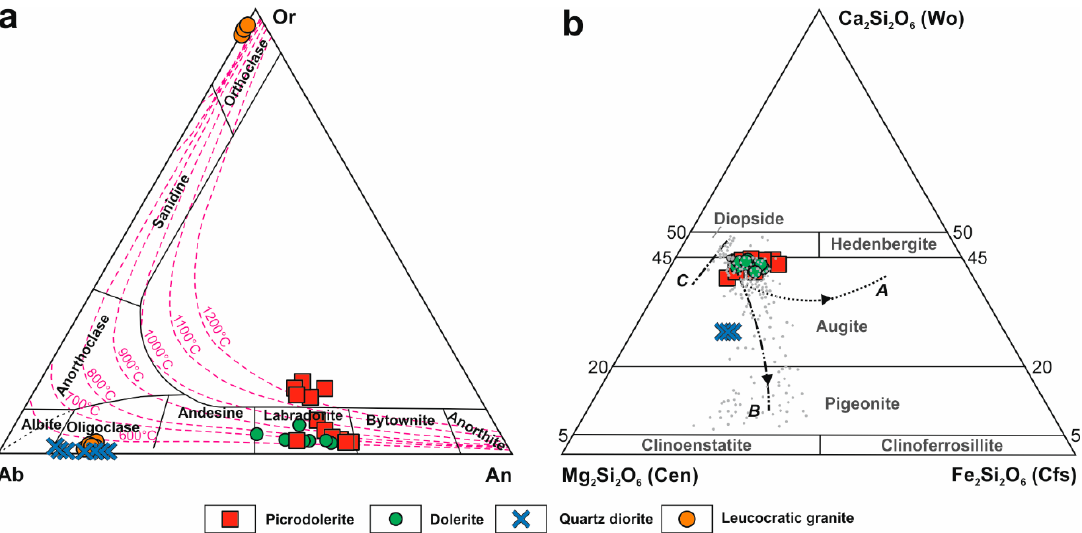
Figure 5. Composition of minerals from the dike rocks on classification diagrams: for plagioclases from [38] ( a ), for clinopyroxenes from [39] ( b ). Composition lines for clinopyroxenes are given for igneous rocks of: A —intraplate settings, picrites, subalkaline gabbros and syenites, Skaergaard intrusion, Greenland [40]; B —active continental margin settings, basalts, basaltic andesites, dacites, Hudson Volcano, Chilean Patagonia [41]; C —island arcs, basalts and gabbros, back-arc basins Ispendere, Malatya, southwestern Anatolia [42]. Arrows on lines A and B show directions of changes in pyroxenes compositions with rising SiO 2 content in the rocks. Grey dots show compositions of clinopyroxenes from basalts associating with high-K rocks of the Kuril Islands and the Kamchatka active continental margin from [43].